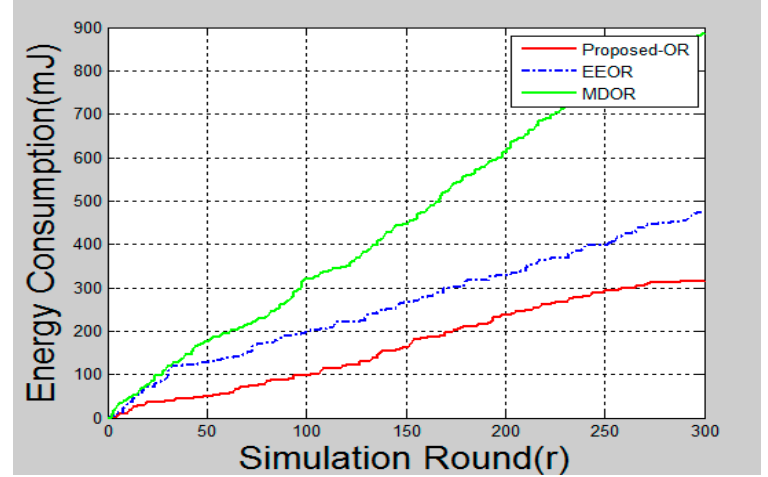
Figure 5. Total energy consumption.